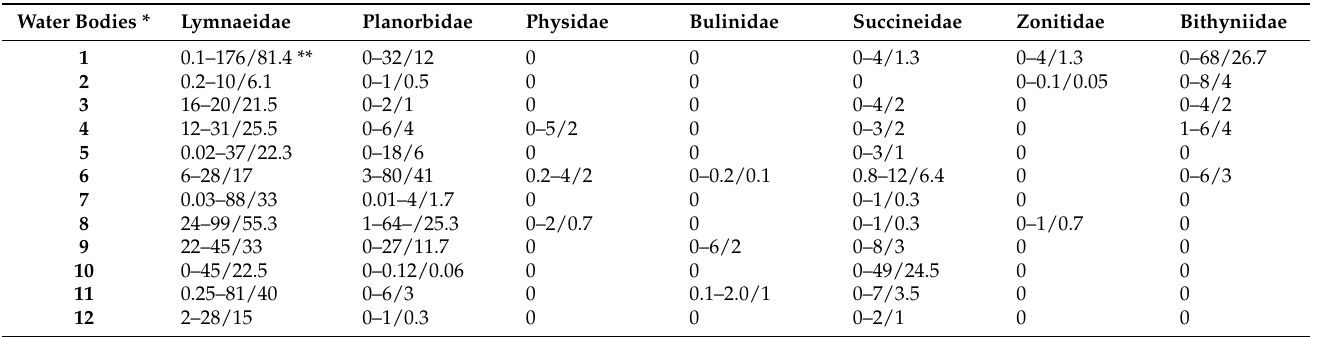
Table 3. Abundance (ind./m 2 ) of gastropods in August 2009 from water bodies of northern Kulunda (Novosibirsk